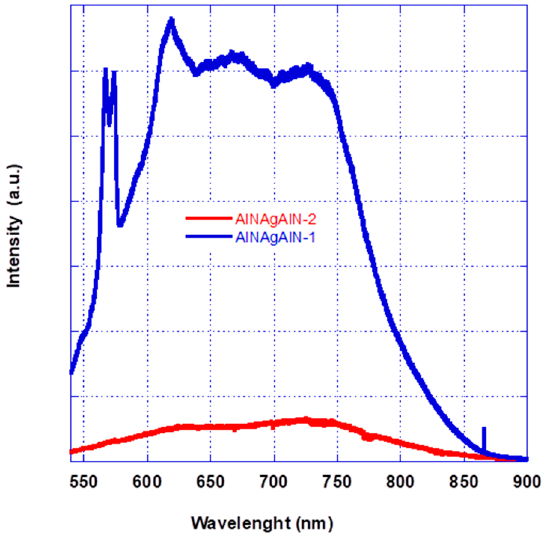
Figure 10. Thin-film photoluminescence comparison of AlN_Ag1 and AlN_Ag2 samples.